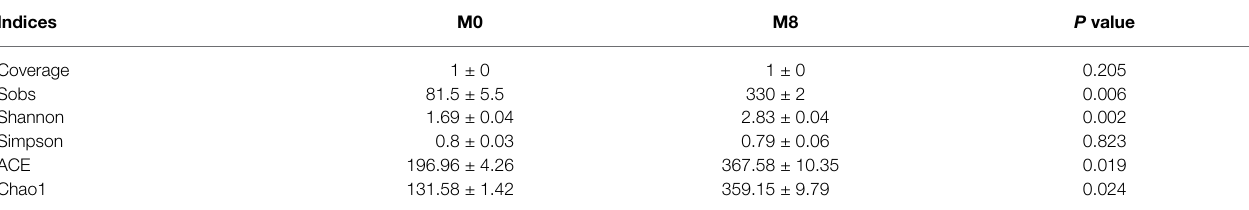
TABLE 4 | Effects of methionine restriction on gut bacterial diversity indices after feeding for 8 weeks ( n = 3).